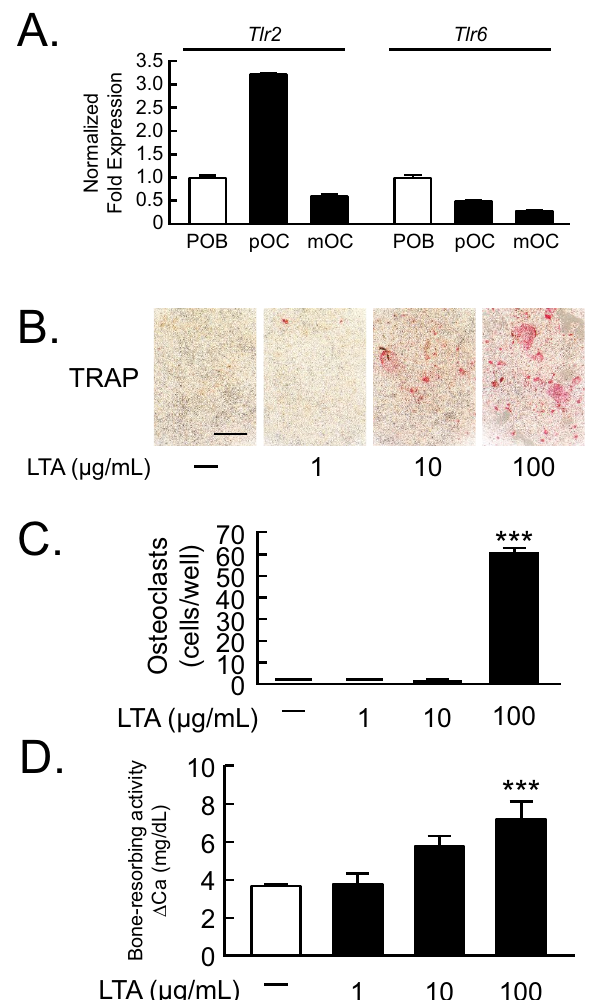
Figure 1. LTA induced osteoclast differentiation and bone resorption. ( A ) The mRNA expression of TLR2 and TLR6 in mouse primary osteoblasts (POBs), Raw264.7 cells (osteoclast precursor cells; pOC) and sRANKL- treated Raw264.7 cells (mature osteoclasts; mOC). The data are expressed as the means ± SEM of triplicate from a representative experiment. β-actin ( Actb ) was used as a normalized gene. ( B ) Mouse POB and BMCs were co-cultured with LTA (1, 10, 100 μg/mL) for 6 days. The images showed TRAP-positive multinuclear osteoclasts. Scale bar: 500 μm. ( C ) TRAP-positive multinuclear osteoclasts were counted. The data are expressed as the mean ± SEM of 3 wells. ( D ) Mouse calvariae from newborn mice were cultured with LTA (1, 10, 100 μg/mL) for 5 days. The calcium concentration was measured to elucidate bone-resorbing activity. The data are expressed as the mean ± SEM of 5 wells. A significant difference between the two groups was indicated; *** P < 0.001 versus control; by one-way ANOVA and Tukey’s post hoc